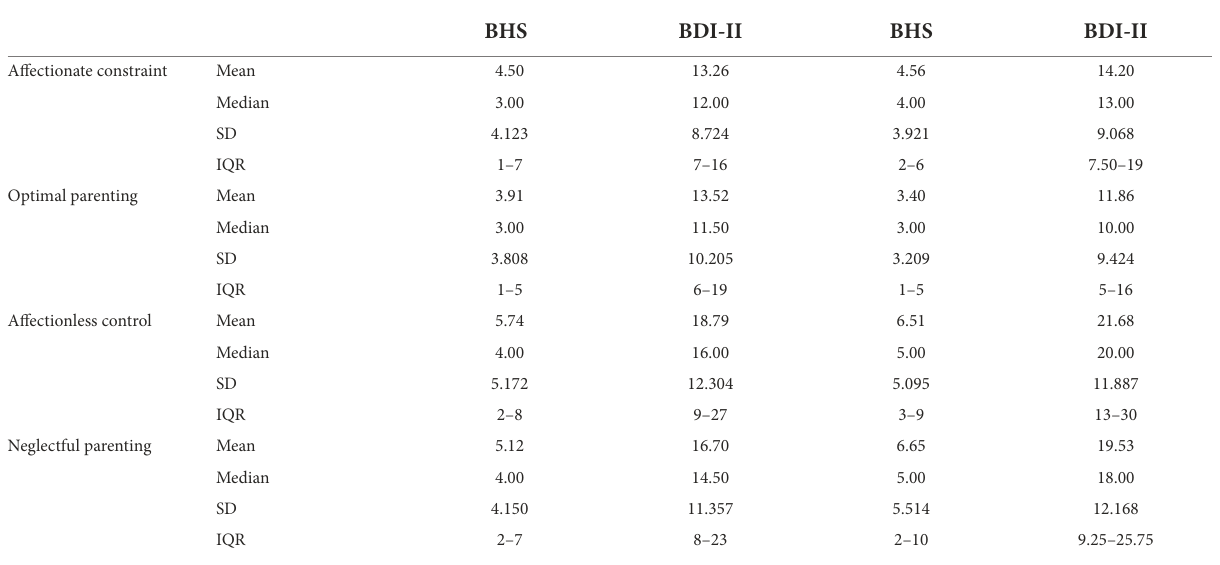
TABLE 5 BHS/BDI-II scores divided among parenting